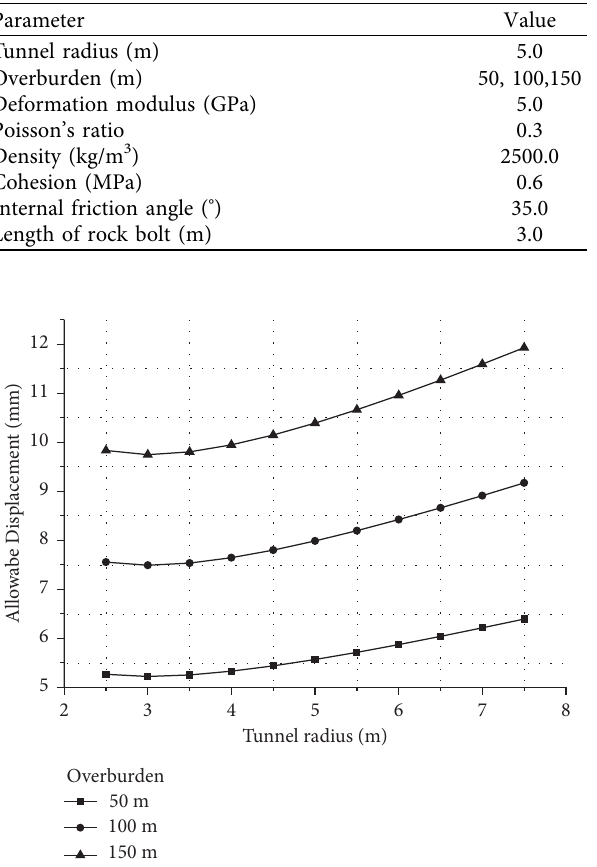
Figure 4: The curve of allowable displacement vs. tunnel